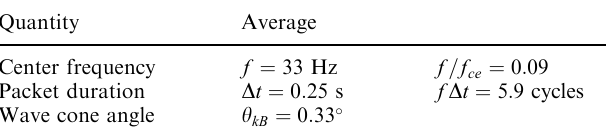
Table 1. Average frequency, wave packet duration, and cone angle between wave vector and ambient field for 356 cases Quantity Average Center